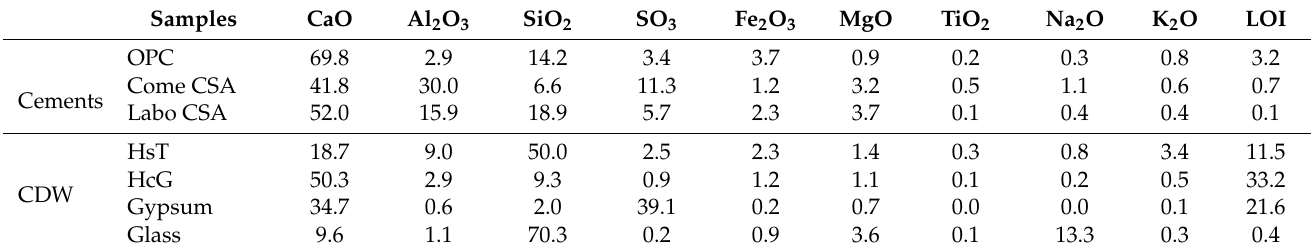
Table 1. Chemical composition of the starting materials, identified using XRF.